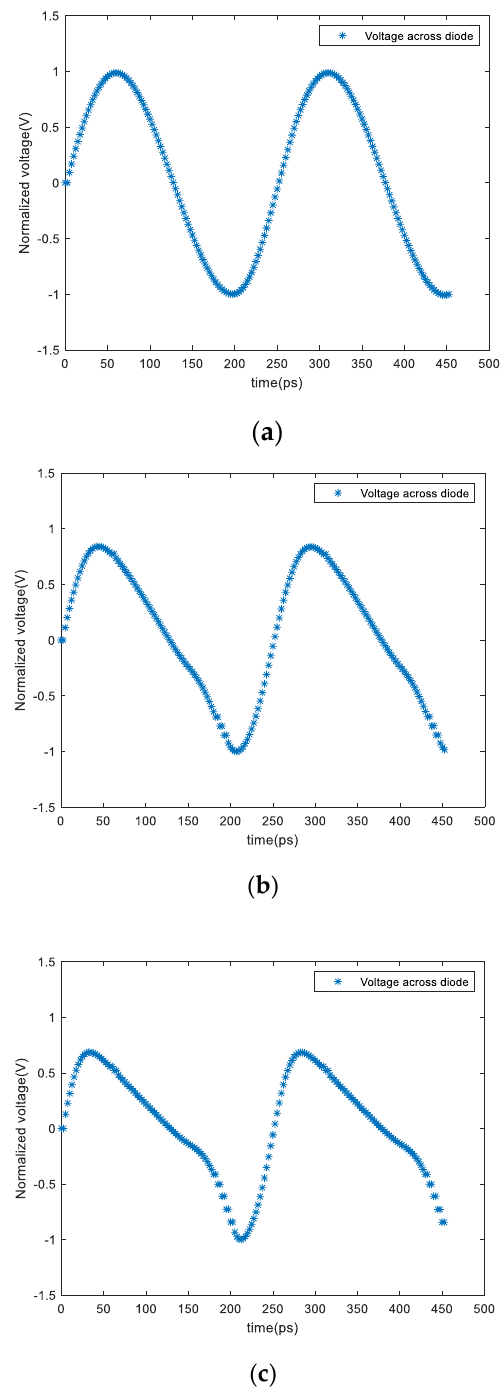
Figure 8. Diode voltage obtained with different amplitudes: ( a ) amplitude of 5 V; ( b ) amplitude of 50 V; ( c ) amplitude of 100 V.